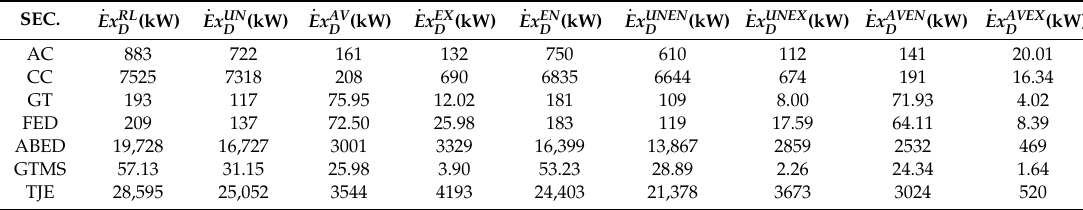
Table A4. Results for endogenous, exogenous, unavoidable and avoidable exergy demolition of TJE and sections for the AB process mode for JP-8 utilization [63].